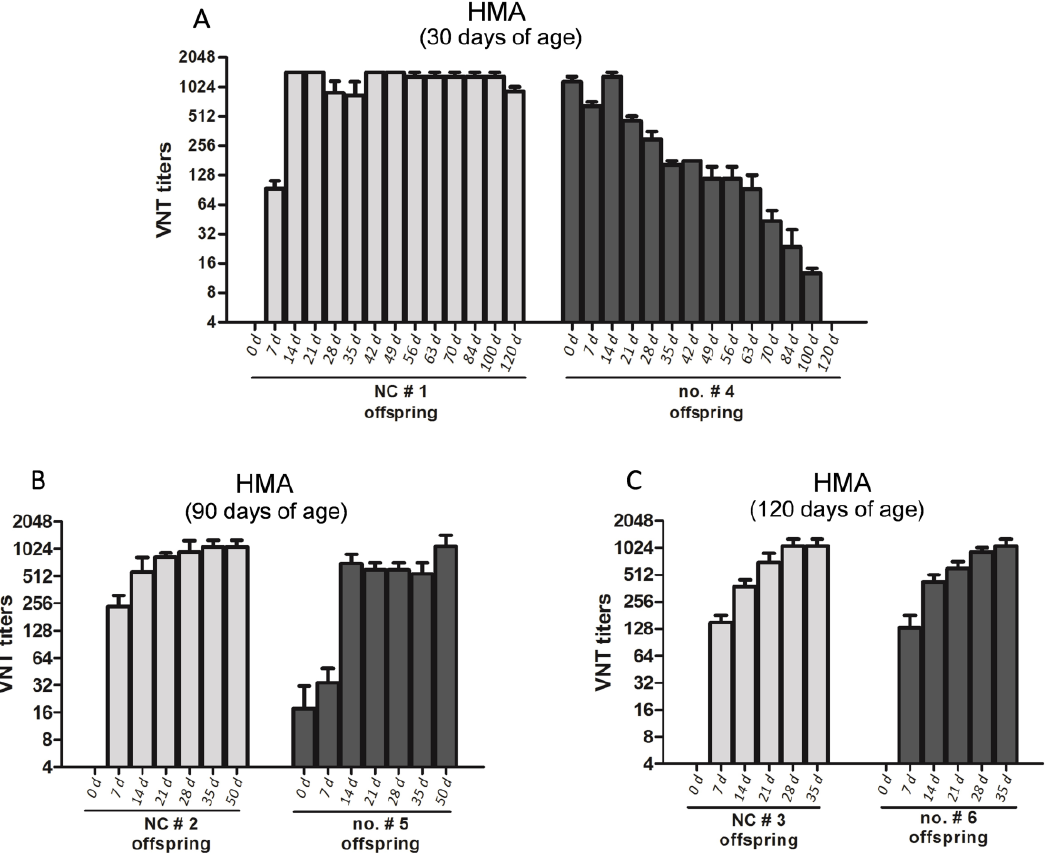
Figure 5. Evaluation of the effect of MDAs on adaptive immune response within the offspring. The offspring of the sows in the PBS control group and the HMA group were immunized with inactivated SVA vaccine (2 µ g of antigen) at 30 ( A ), 90 ( B ), or 120 ( C ) days of age, respectively. The serum samples were collected at the indicated time-point after vaccination and subjected to VNT analysis to evaluate the interfere of the MDAs. All measured values were expressed as the means with standard deviation.